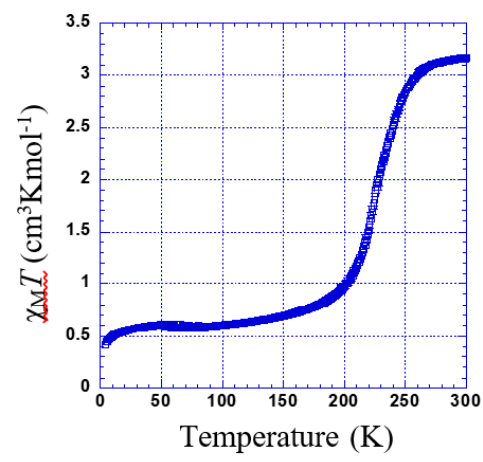
χ M T plot for 3 .